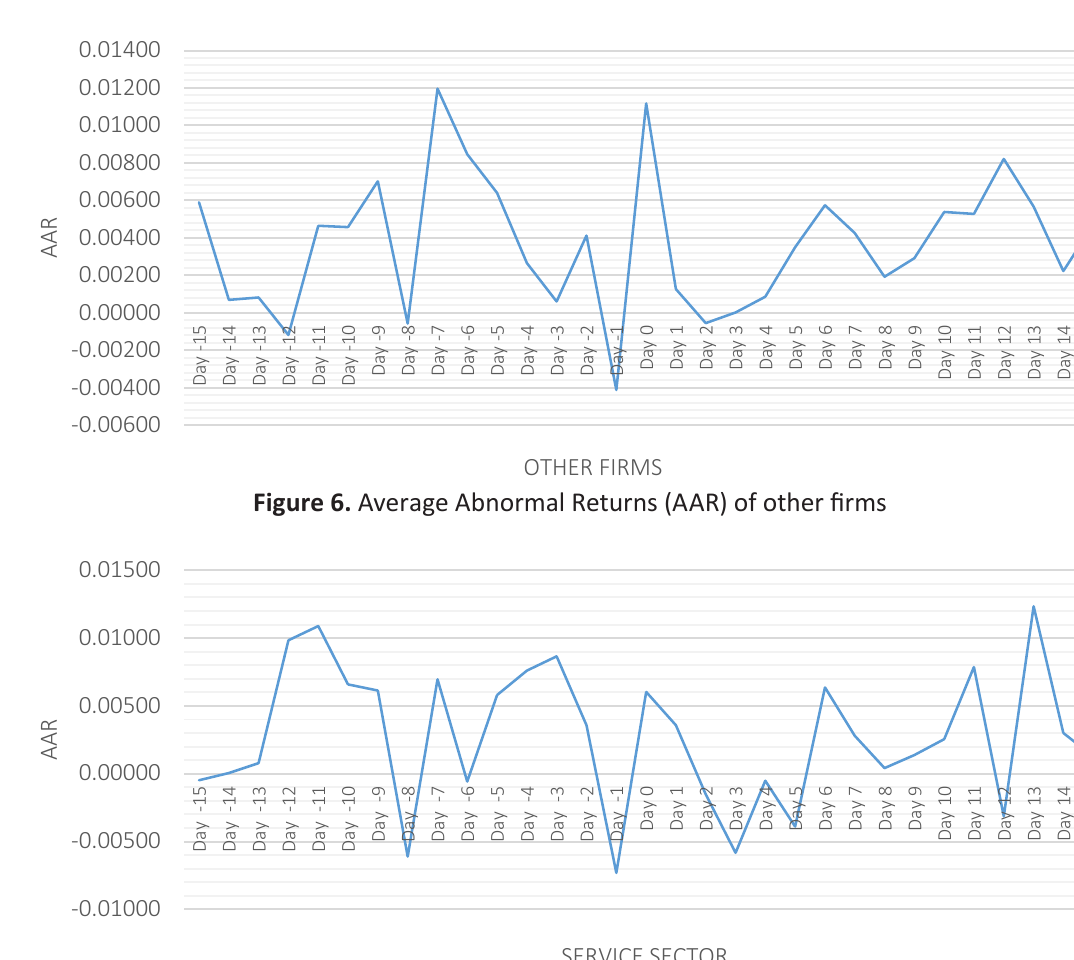
Figure 5. Average Abnormal Returns (AAR) of the Manufacturing Sector